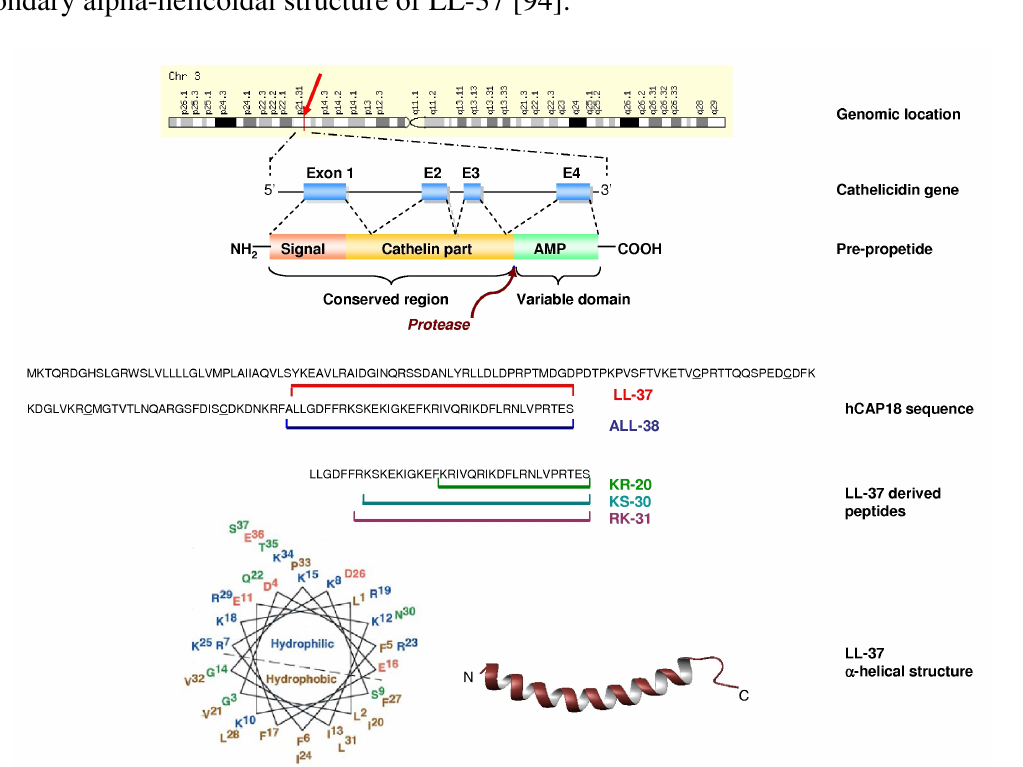
Figure 1: Structure of LL-37. From top to bottom: Location of the cathelicidin gene on the human genome and its structure. Global structure of the pre-propeptide and primary structure of hCAP-18. Sequence of various fragments of LL-37 and model representing the secondary alpha-helicoidal structure of LL-37